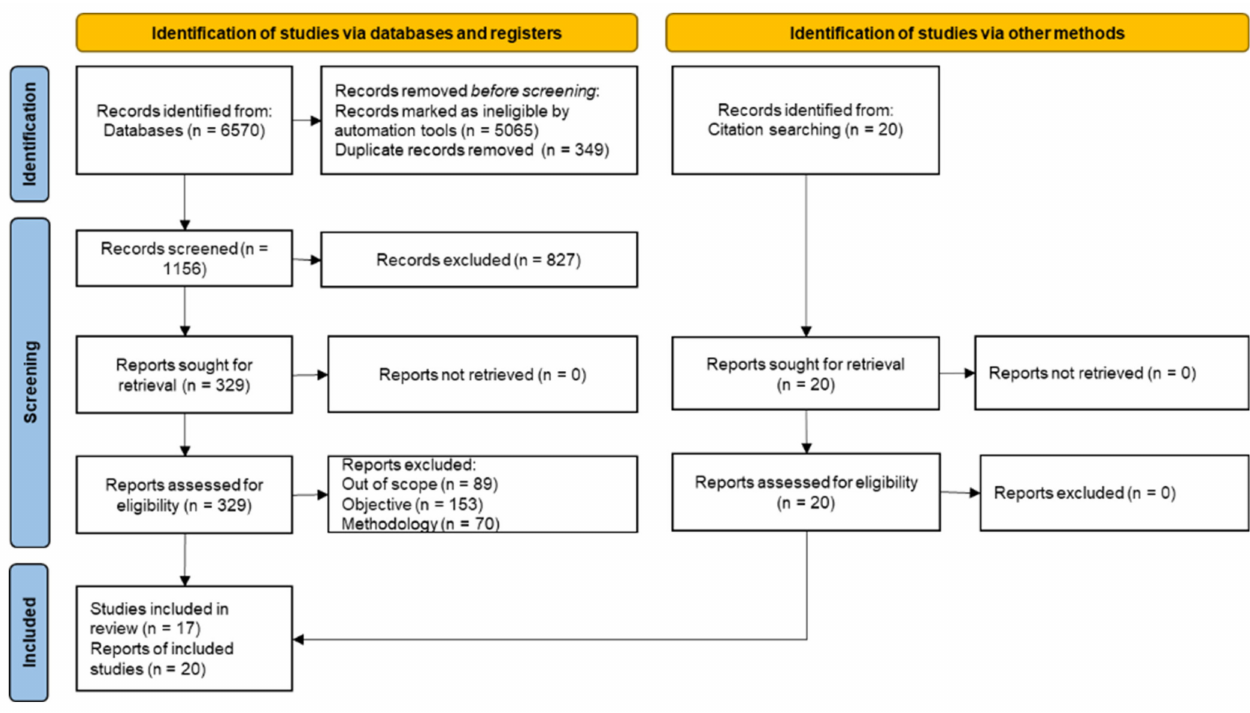
Figure 1. PRISMA Flow diagram of the research [29].